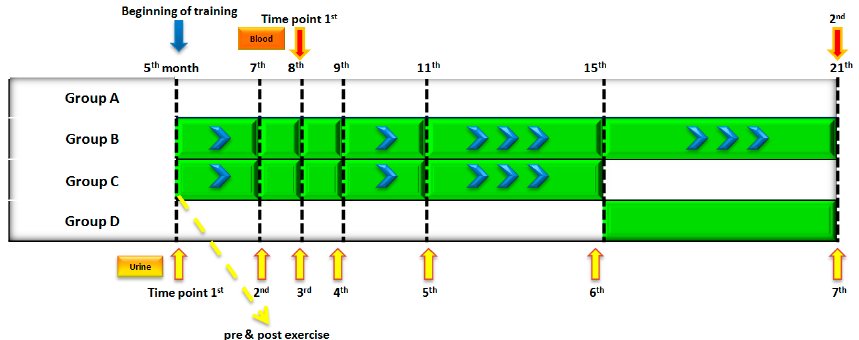
Figure 1. The groups of rats, the training duration and the sample collection time points are illustrated. Urine samples collected at seven sampling time points and one acute training point are marked in yellow. Blood samples collected at two sampling time points are marked in red. A: sedentary group, B: life-long exercise group, trained from 5 to 21 months of age, C: exercise group trained from 5 to 15 months of age, D: exercise group trained from 15 to 21 months of age